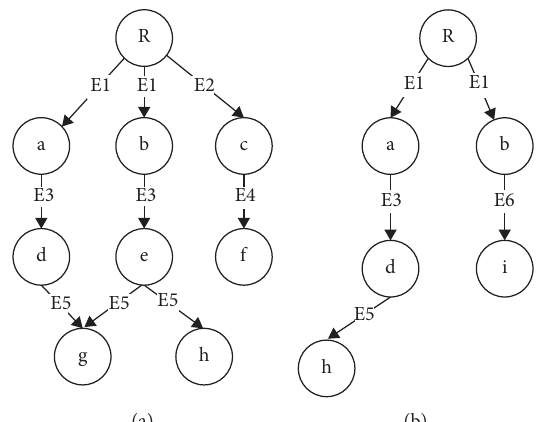
Figure 8: Node set mining graphs: (a) one of the graphs of the node set; (b) other graphs of the node